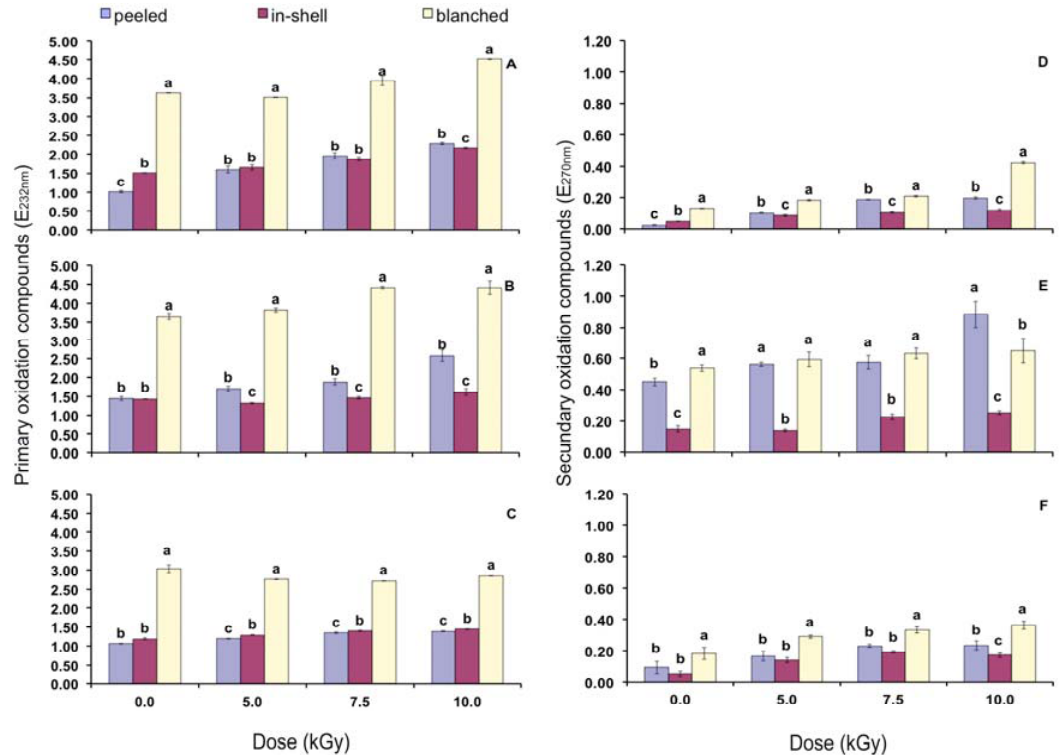
Figure 4. Primary oxidation products on time zero ( A ), after three ( B ) and six months storage ( C ). Secondary oxidation products on time zero ( D ), after three ( E ) and six months storage ( F ). Error bars represent standard deviations of triplicate measurements. Means with the same small letter within a gamma radiation dose are not statistically different by Tukey’s multiple test ( p <